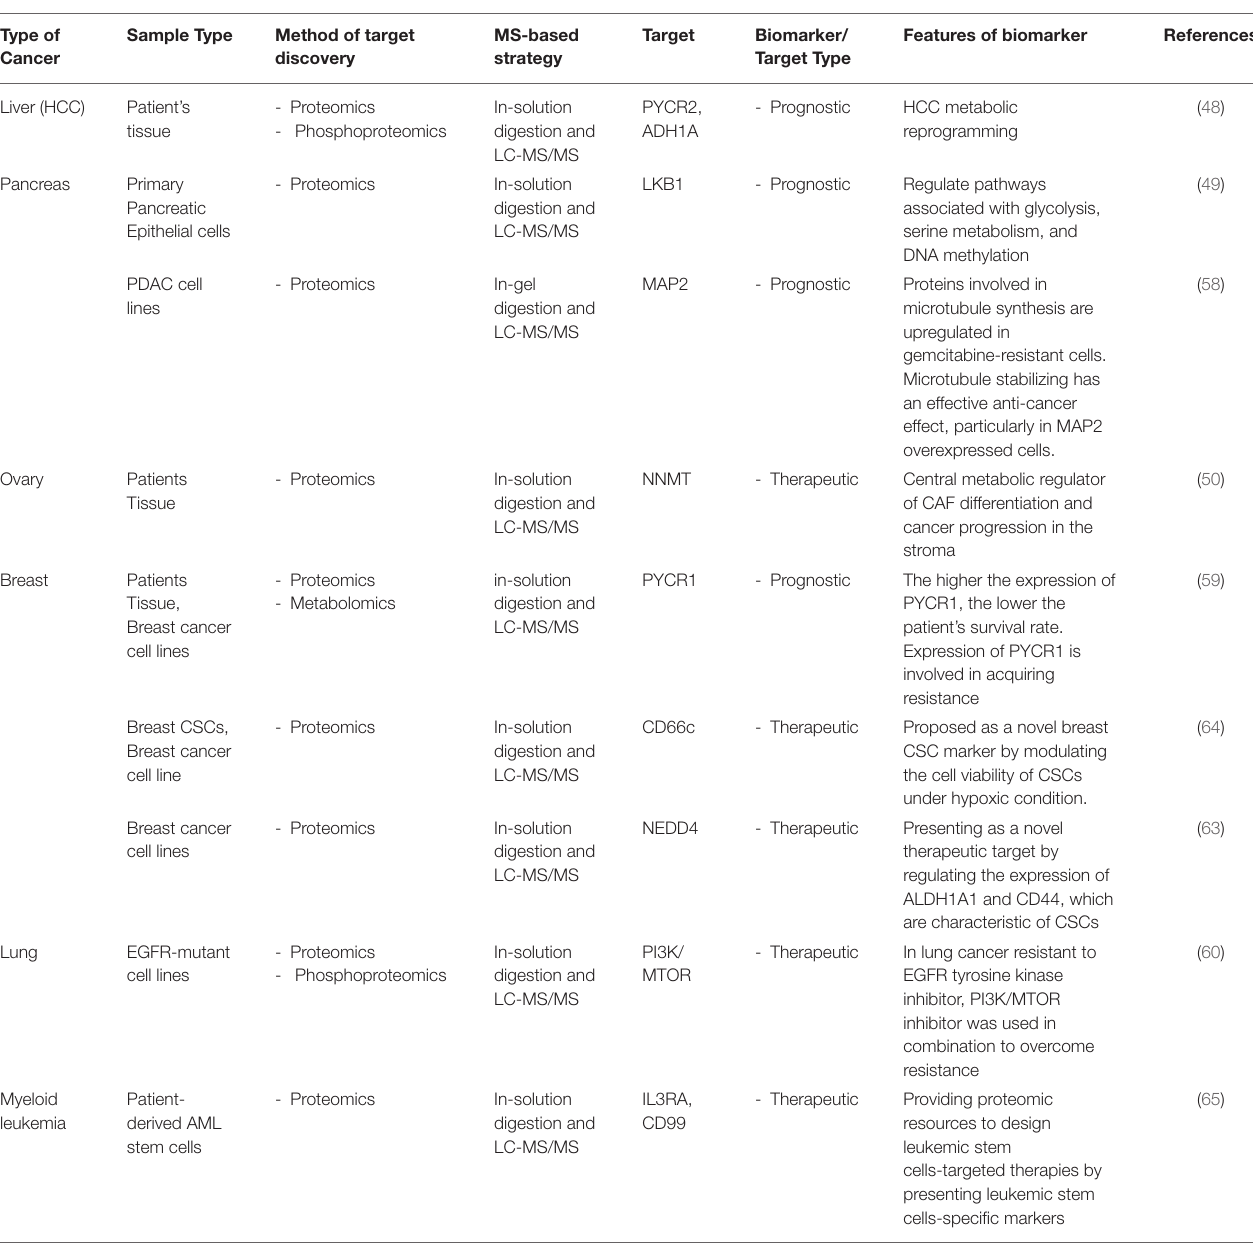
TABLE 2 | List of representative cancer biomarkers identified using proteomics